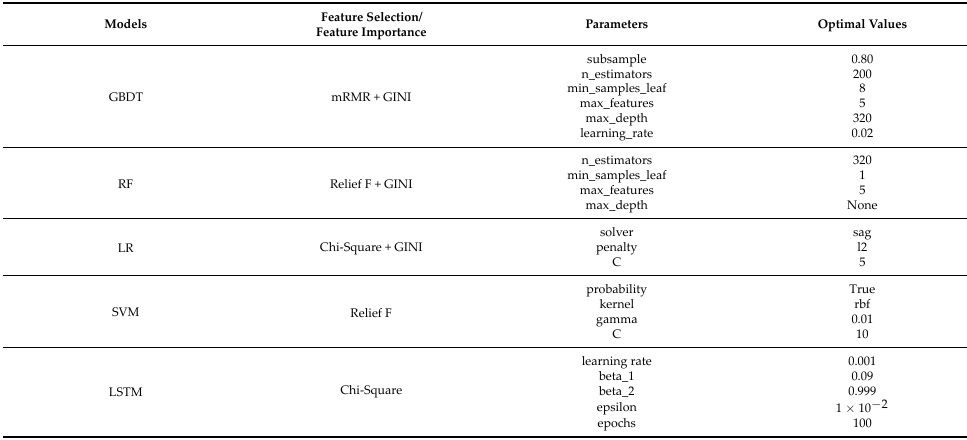
Table 1. Optimizable parameters for different